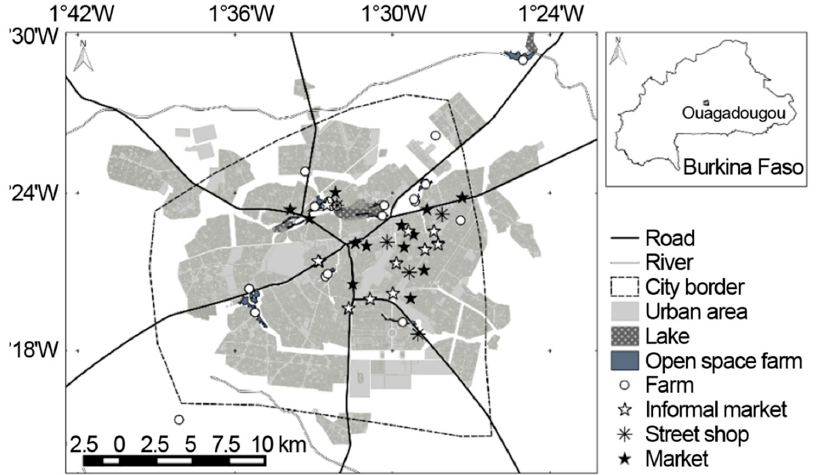
Figure 1. Location of the studied lettuce production farms (circle), in Ouagadougou (Burkina Faso) in 2014 with three different types of markets: Public market (black asterisk), informal market (white asterisk), and street shop (flake).